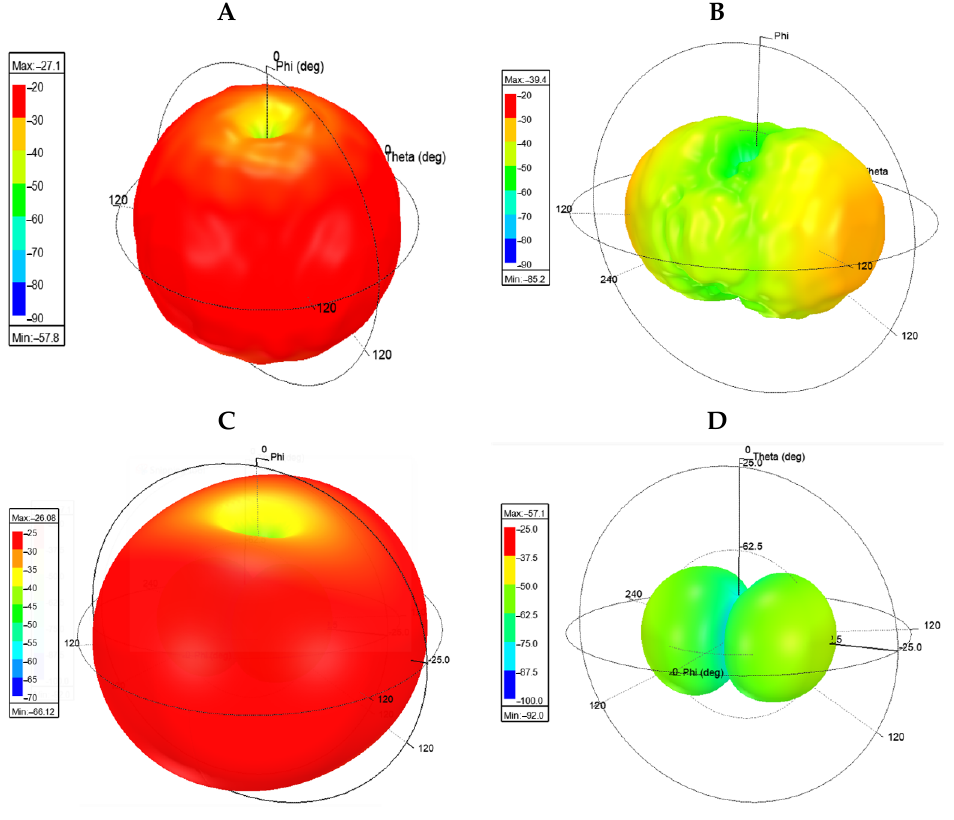
Figure 22. HFSS 3D electric field strength patterns of ELC-based resonators (images courtesy of ANSYS Inc). ( A ) Peak rE of sensor; ( B ) null rE of sensor; ( C ) peak rE of regular ELC; and ( D ) null rE of regular ELC.